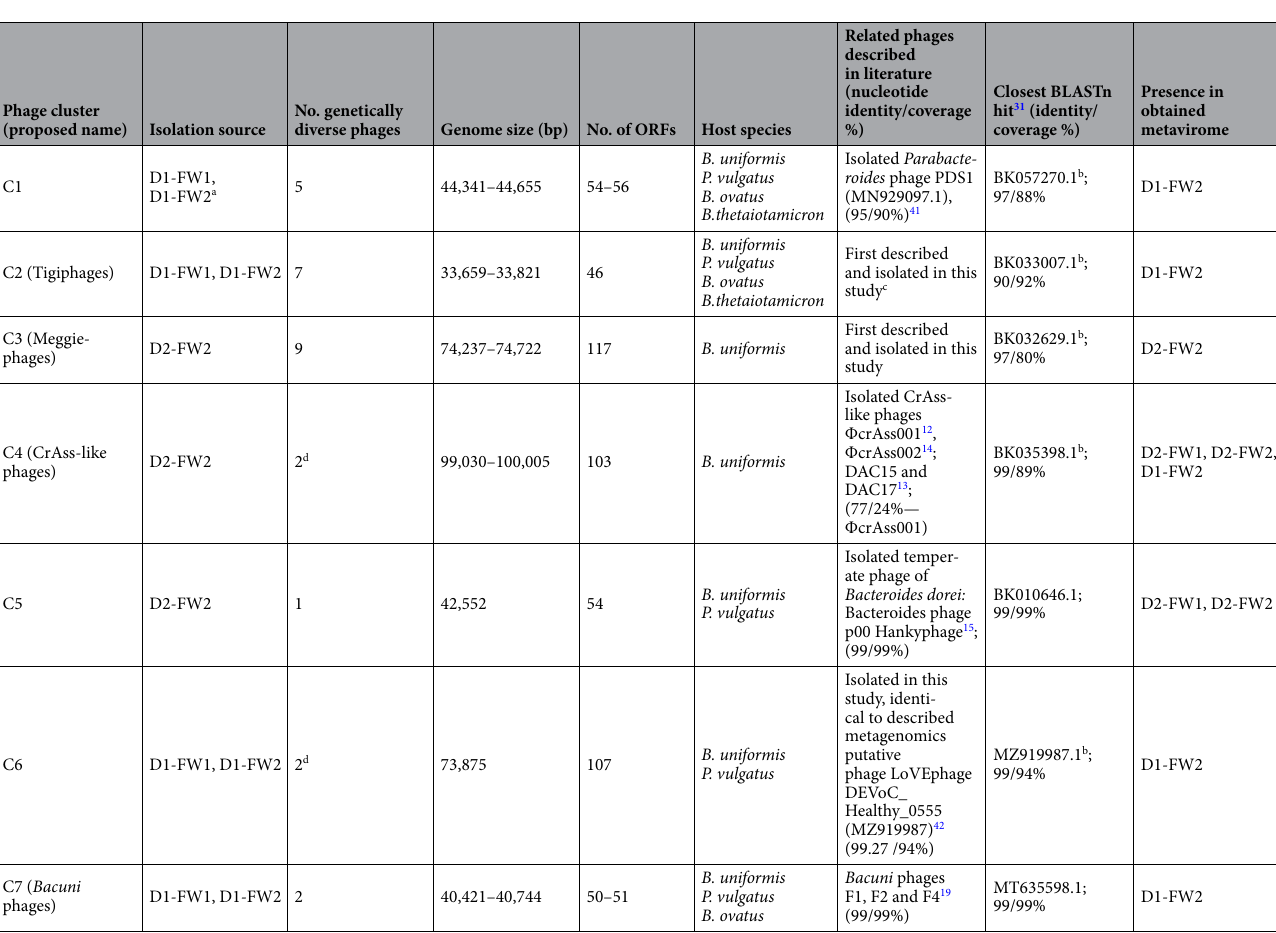
Table 1. Comparison of isolated phage clusters and related phages previously described in the literature. a D, donor; FW, fecal water. b Assembled putative viral contig from metagenomic data. c App. 57% amino acid identity in 20% of ORFs with B. thetaiotaomicron infecting alpha cluster phages from 13 . d Partial viral genomes in